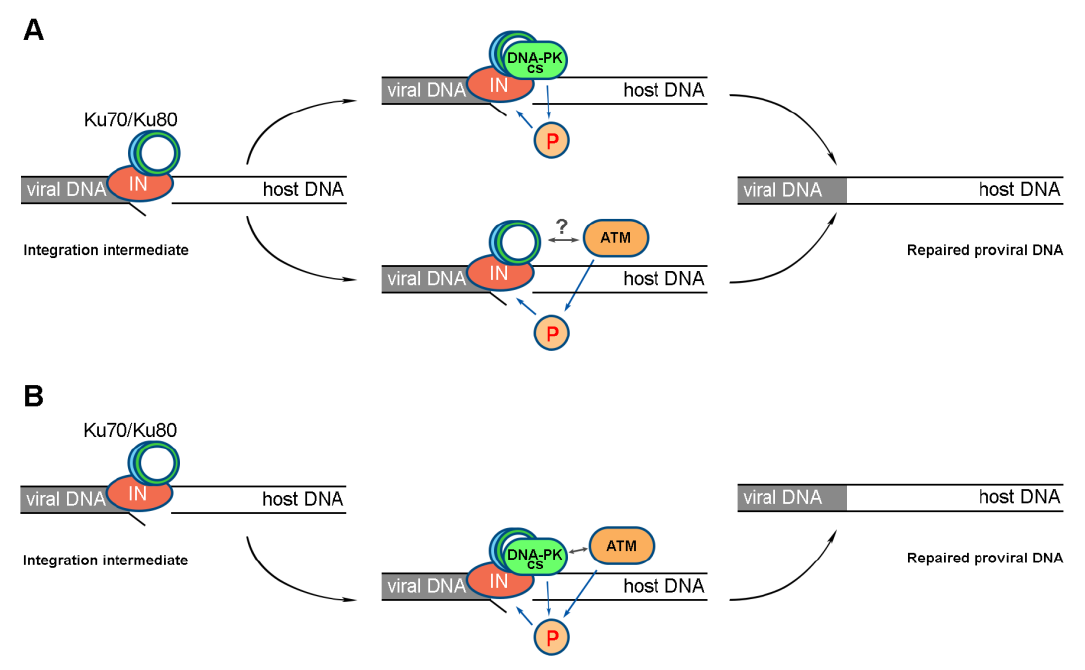
Figure 4. Models of ATM and DNA-PKcs activation during HIV-1 PIR. ( A ) The parallel activation model suggests that activation of either of the two kinases at the site of integration can lead to PIR activation and successful completion of this process. ( B ) The sequential activation model suggests that activation of both kinases is required for successful PIR to occur. For both models, activation of ATM and DNA-PKcs depends on the formation of the IN-Ku70 complex.